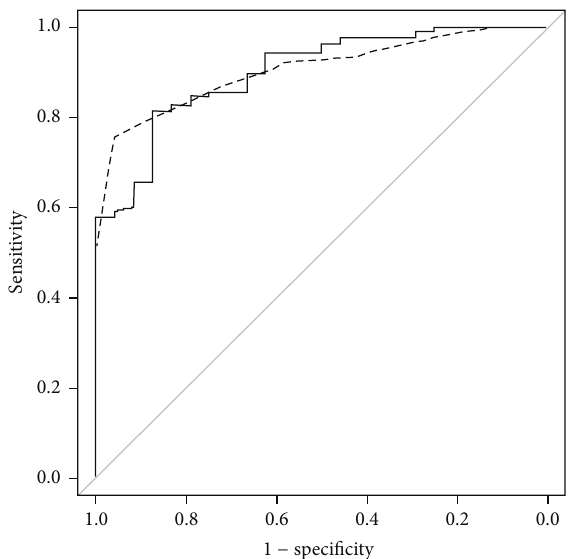
Figure 3: ROC curves of the scoring system used to predict the visual prognosis of acute-onset VH of preoperatively unknown origin. The solid line shows the ROC curves of four variables (age, baseline BCVA of the affected eye, baseline BCVA of the unaffected eye, and age-related macular changes in the fellow eyes), which were significantly associated with poor visual acuity following vitrectomy. The dashed line shows the ROC curve of the scoring system. The AUC of the scoring system was 0.907 (95% CI =